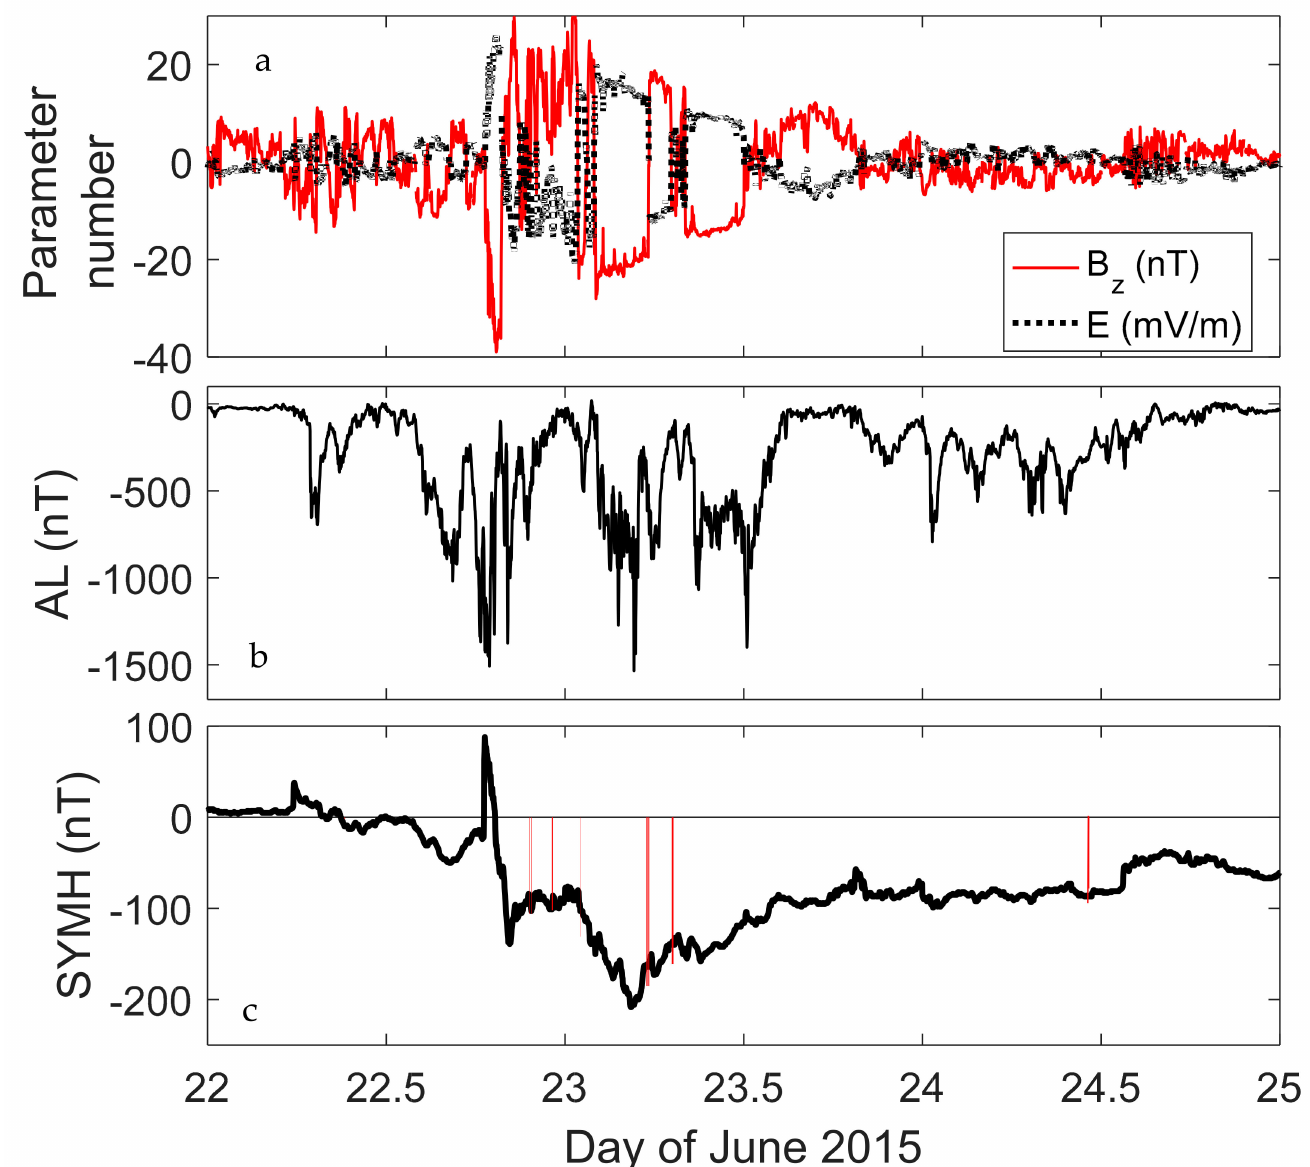
Figure 11. The solar wind and geomagnetic indices associated with the super storm observed from 22 June 2015 to 24 June 2015. ( a ) The IMF B z and solar wind electric field, ( b ) The AL index, and ( c ) The SYMH